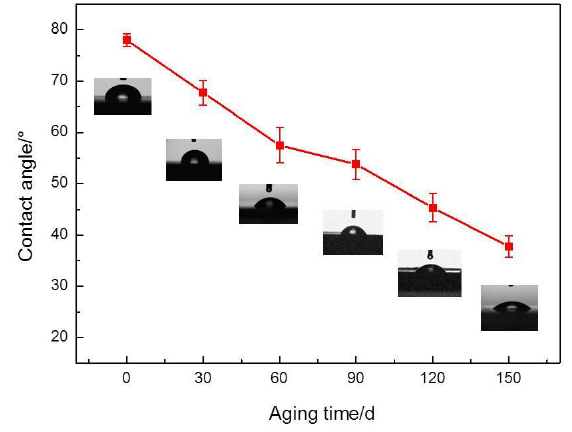
Figure 4. Change in contact angle with aging time.